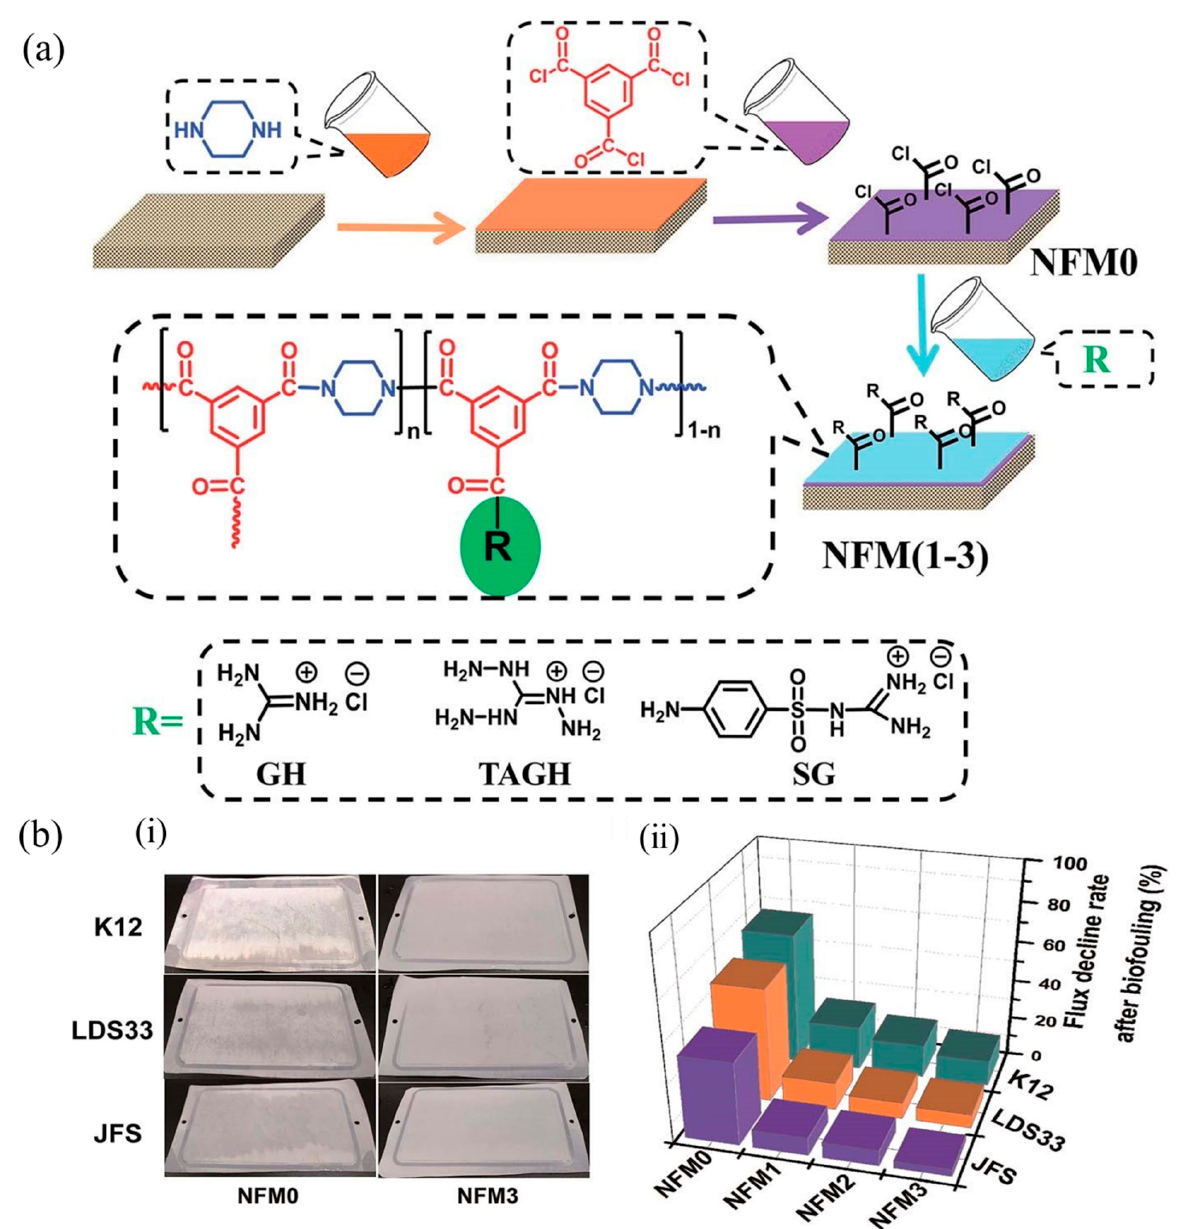
Figure 7. ( a ) Schematic diagram for the fabrication of guanidine-functionalized PA-TFC NF mem- branes. ( b ) (( i ) Photographs of raw membrane (NFM0) and guanidine-functionalized membrane (NFM3) after 48 h exposure to K12, LDS33 and JFS suspensions and ( ii ) the water flux decline rate of NFMs after biofouling[109]). (Copyright (2018) with permission from Royal Society of Chemis- try).